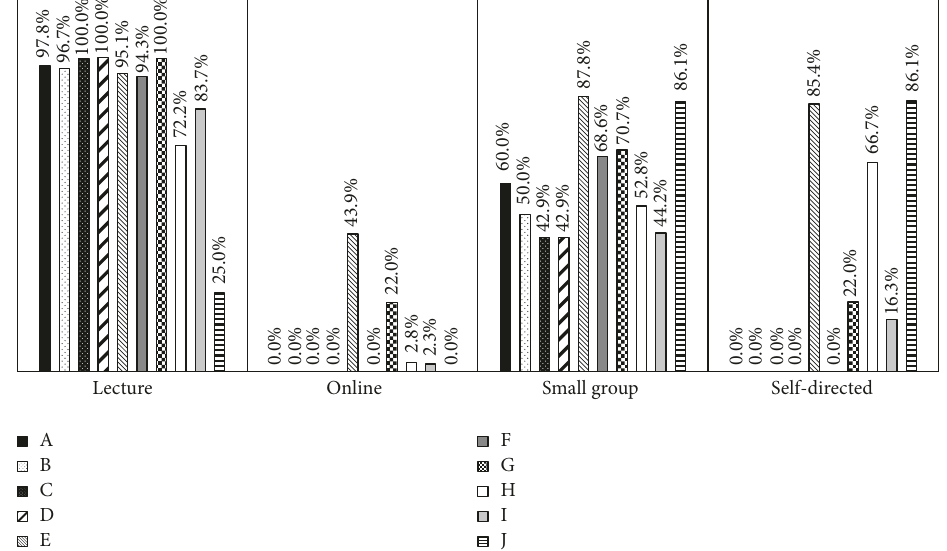
Figure 4: Teaching methods by Canadian medical schools.